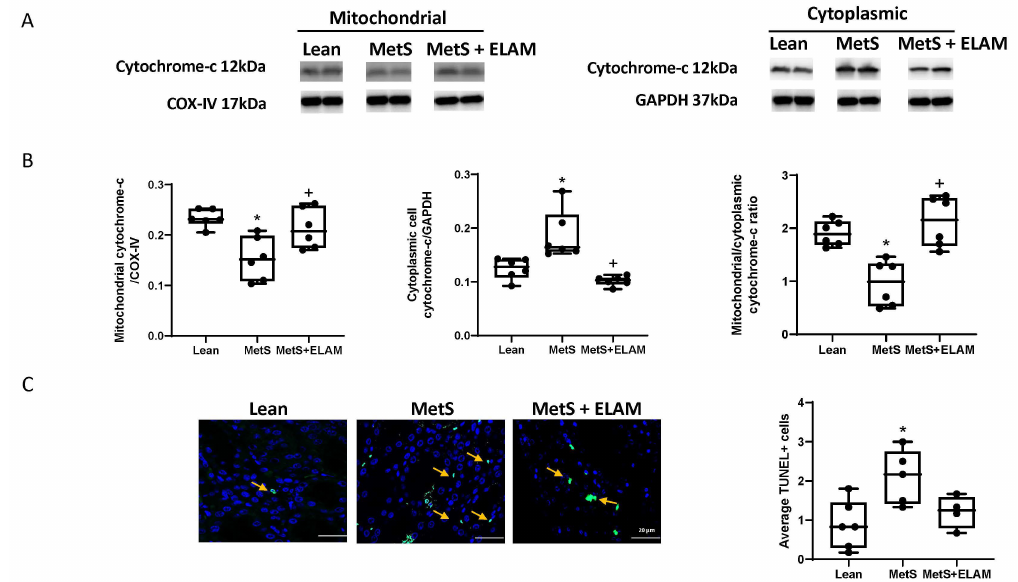
Figure 3. The degree of renal cell apoptosis in MetS was assessed by: ( A , B ) Cytochrome-c expression in mitochondrial compared to the cellular fraction. ( C ) TUNEL staining (yellow arrows showing apoptotic signals); Apoptosis increased in MetS and partly decreased in MetS + ELAM, suggesting improved mitochondrial function and cell survival. * p < 0.05 vs. lean, + p < 0.05 vs. MetS. Mean and median are shown as horizontal lines and accent marks, respectively. Scale bar = 20 µ m.